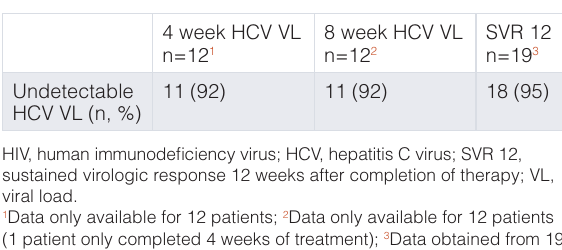
Table 2. Treatment outcomes in 19 HIV and HCV co-infected patients treated with sofosbuvir and